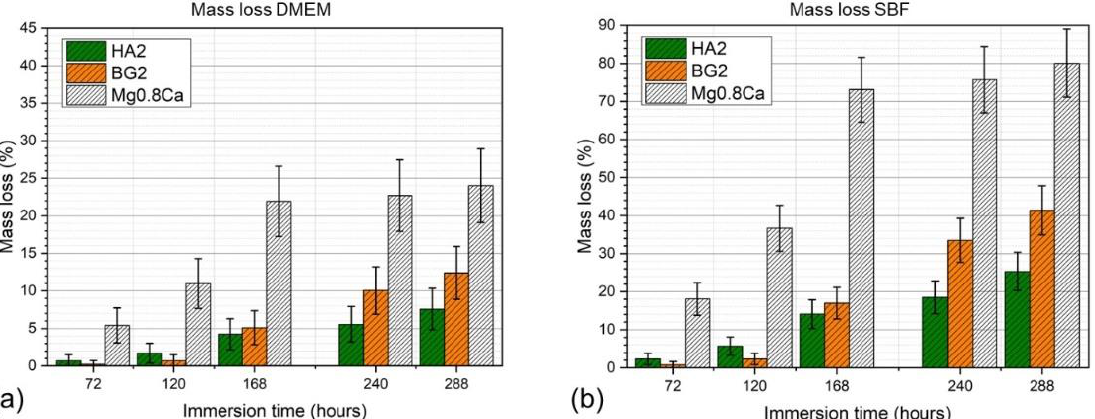
Figure 5. Mass loss time evolution in ( a ) DMEM and ( b ) SBF testing media of the bare and HA2- and BG2-coated Mg-0.8Ca specimens.